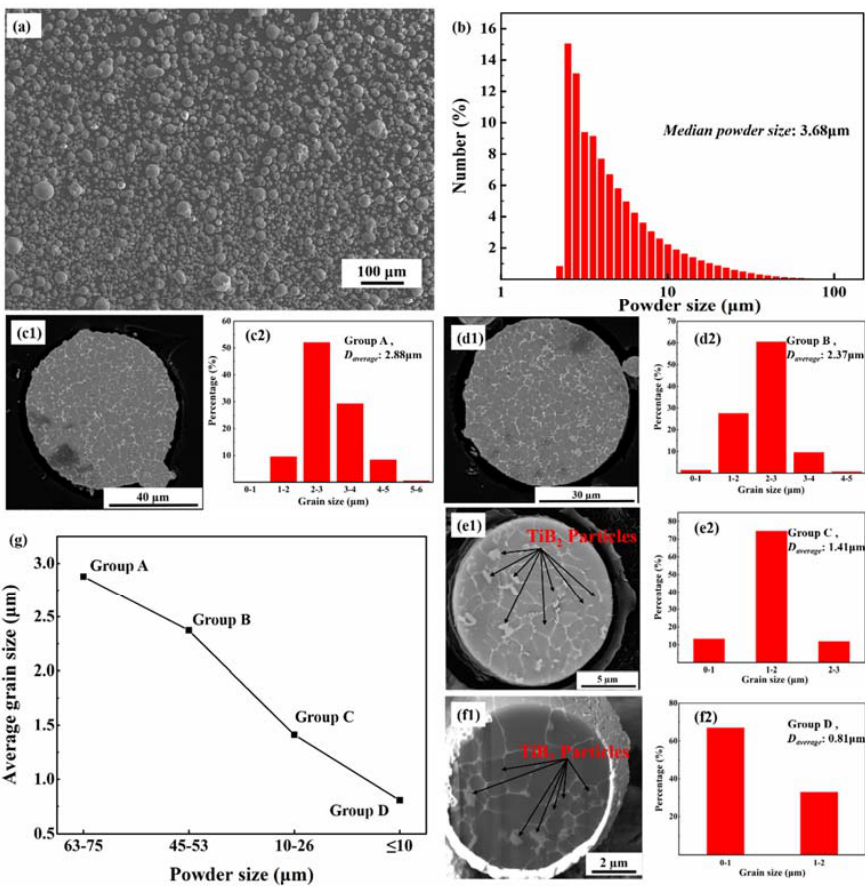
Figure 2. SEM morphology ( a ) and powder size distribution ( b ) of the atomized TiB 2 ‐ reinforced